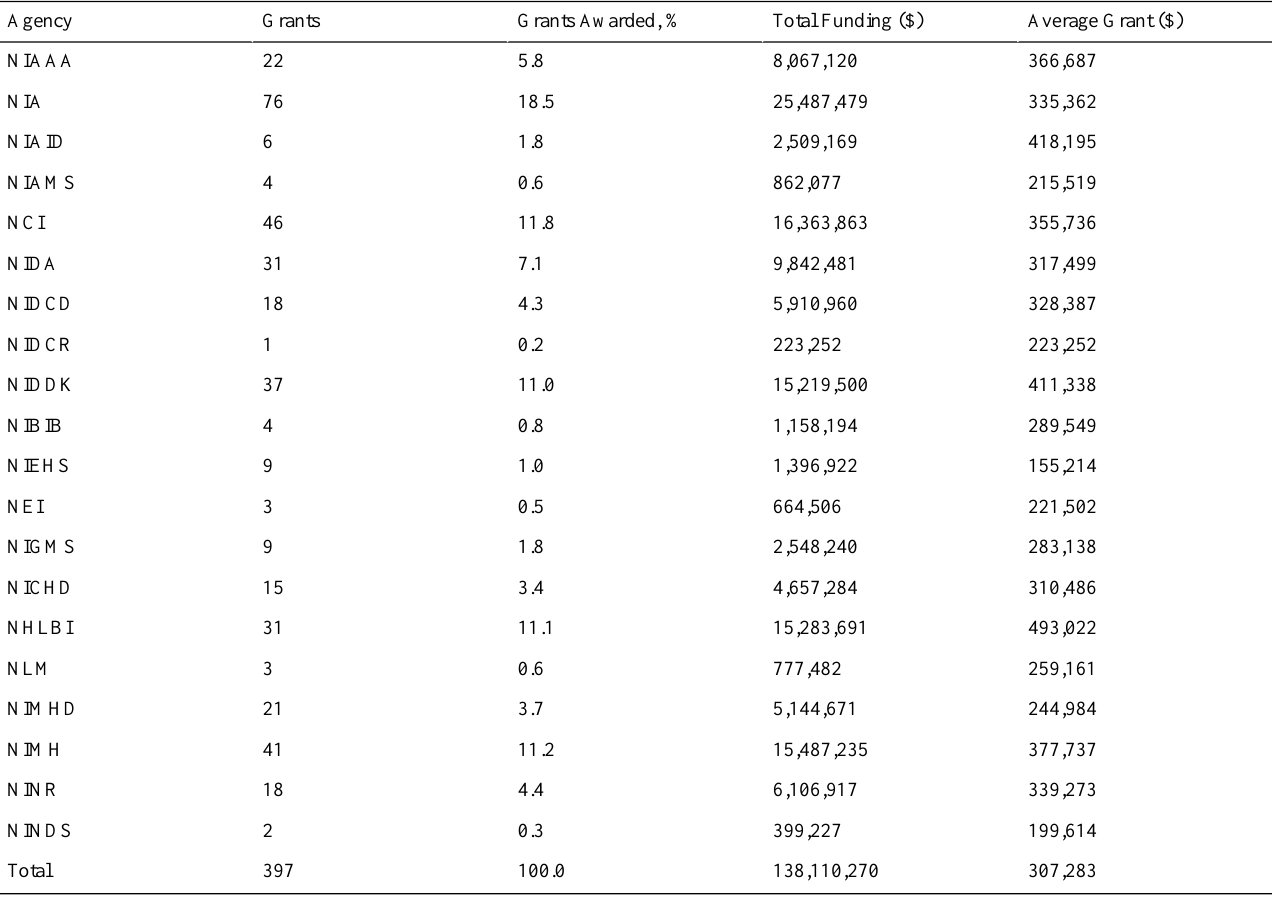
Table 2. Smartphone 1-year grant awards by NIH